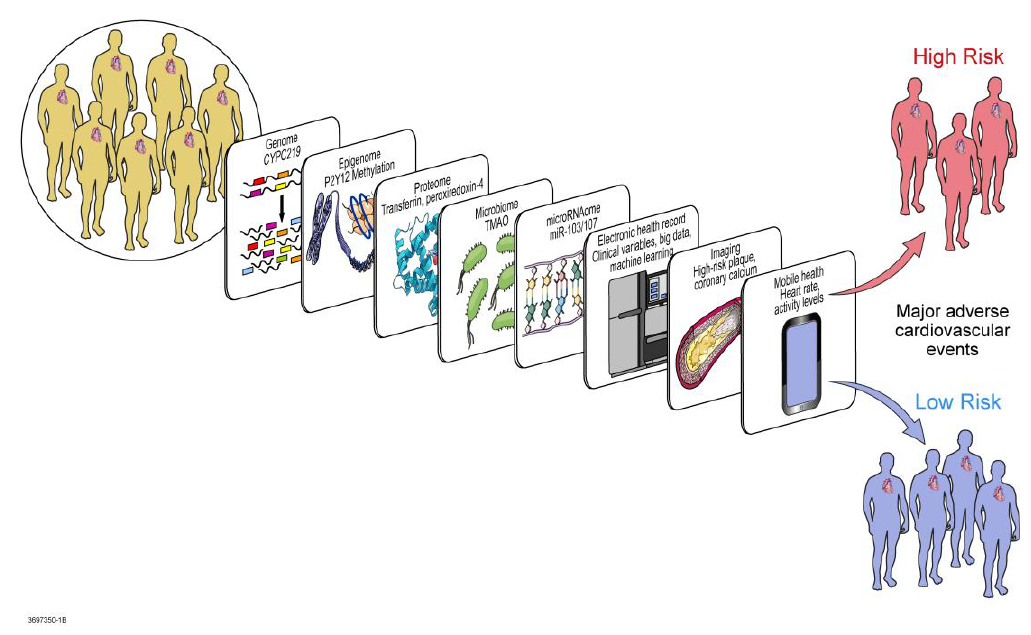
Figure 4. Systems Medicine tools for CYP450 regulation in Precision Cardiovascular Medicine.